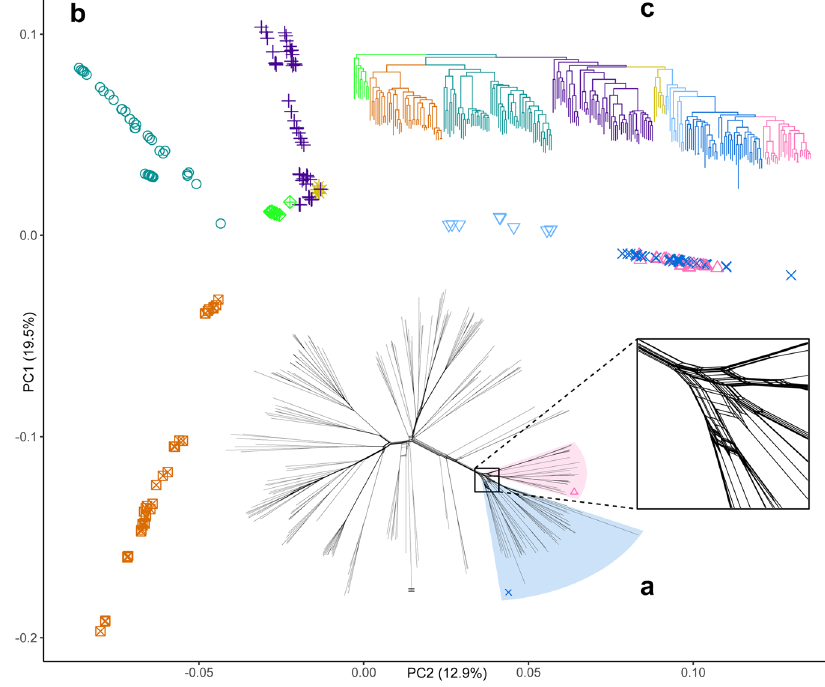
Fig. 3 | Principal component analysis and phylogenetic reconstructions of single nucleotide polymorphism variation within Syzygium . a A NeighborNet phylogenetic network shows considerable character discordance among genome- wideSNPsthatmaybeindicativeofincompletelineagesorting.Thisdiscordanceis particularly noteworthy at the highly webbed base of the Syzygium grande group (close-up view in square inset; see also the labelled network in Supplementary Fig. 89). b PCA of principal components 1 and 2 of Syzygium subg. Syzygium indi- viduals. Clinal patterns are readily observed; the Syzygium grande group (centred